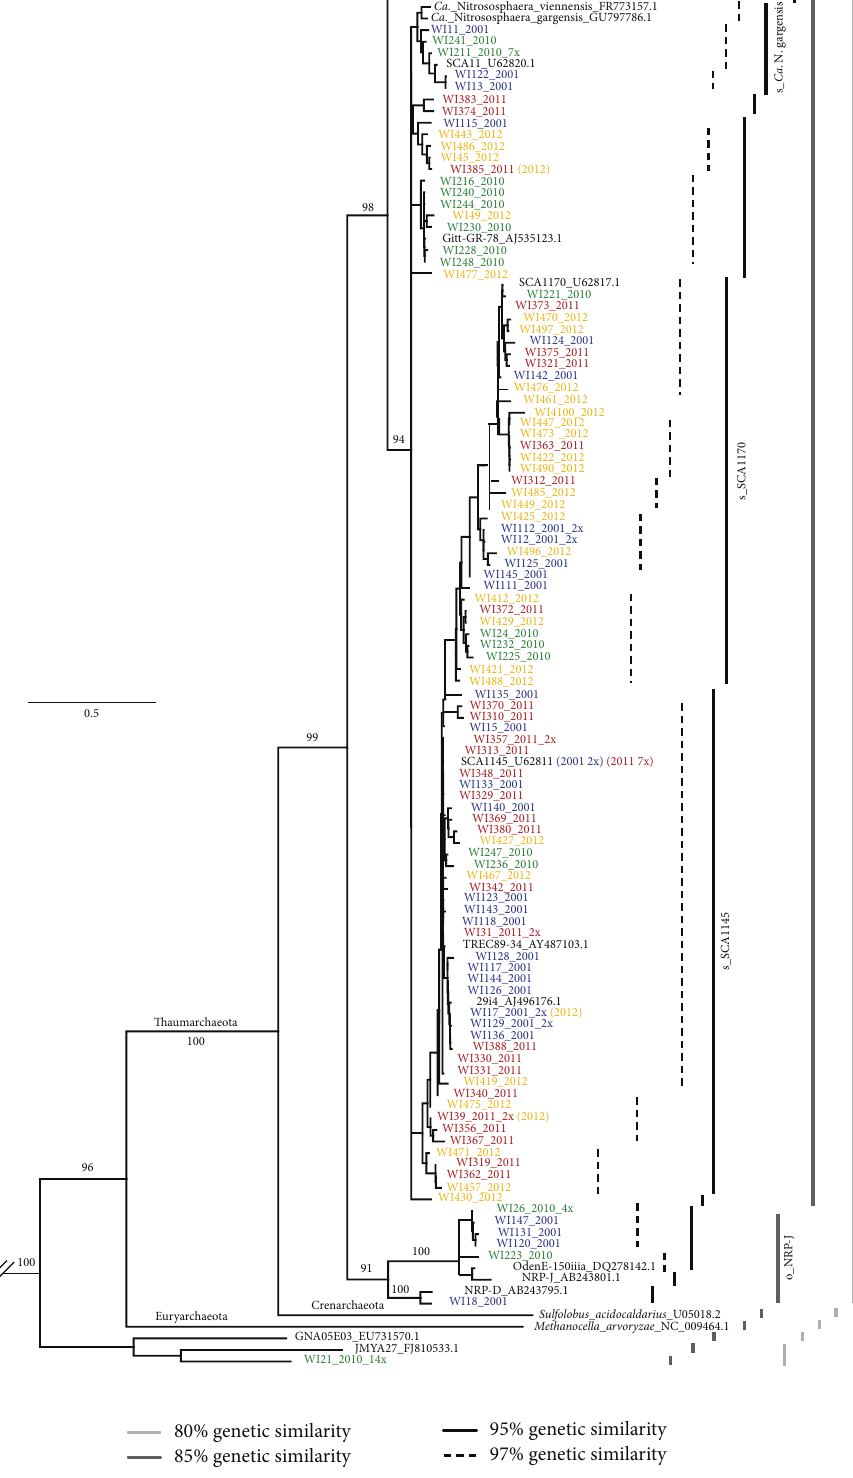
Figure 4: Phylogenetic tree showing the relationships of 16S rRNA sequences recovered from Stone’s Pocket over time. Clones recovered multiple times at 100% sequence identity are indicated with the number of times they were identified listed in parentheses. OTUs at various